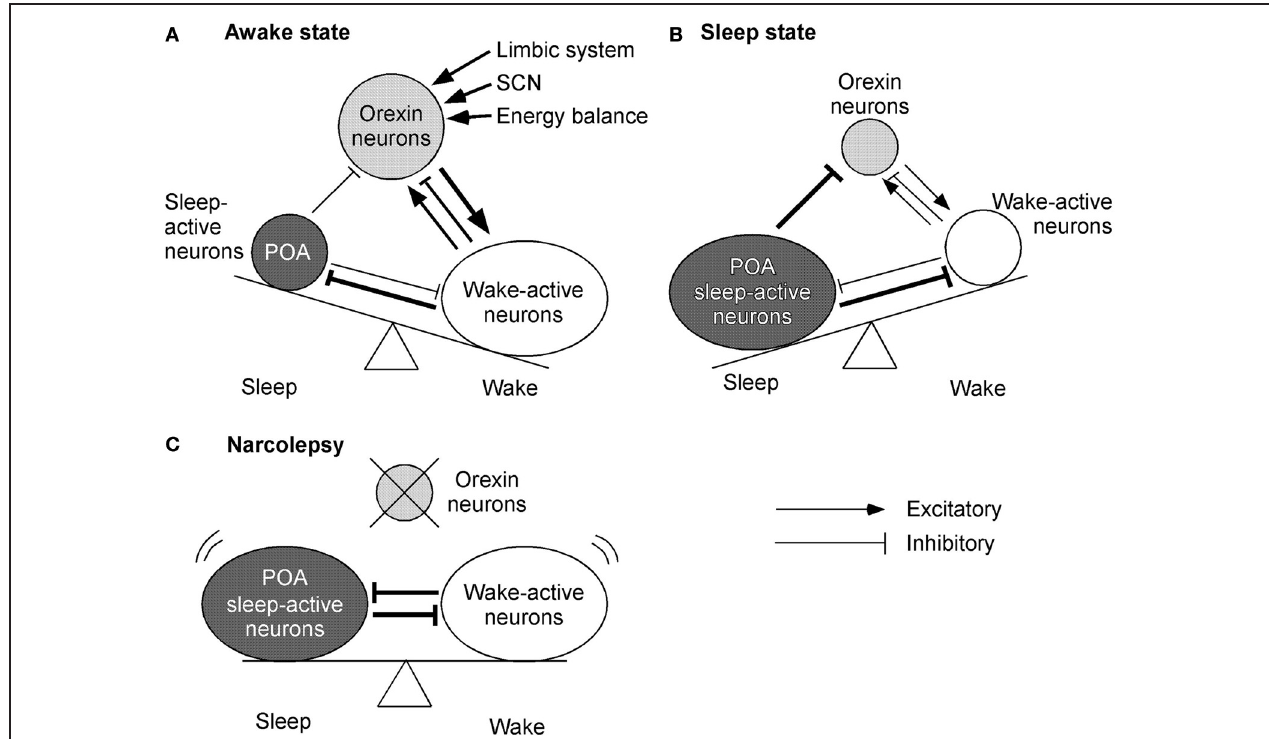
are disinhibited and increase their excitatory influence on wake-active neurons to maintain their activity. These wake-active neurons send inhibitory projections to the POA sleep center and excitatory projections to the thalamus and cerebral cortex. (B) Sleep state. GABAergic neurons in the sleep center are activated and send inhibitory projections to wake-active neurons and orexin neurons to maintain a sleep state. (C) Model of narcolepsy. Sleep-active neurons in the POA inhibit wake-active neurons and in turn are inhibited by them, thus forming a mutually inhibitory system. This system can cause unnecessary transition between the states, because when either side begins to overcome the other, the switch abruptly turns into the alternative